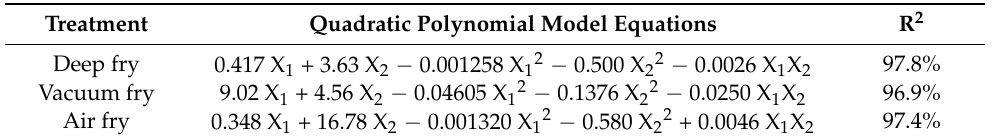
Table 1. Response surface model equations of chub mackerel ( Scomber japonicus ) for different frying